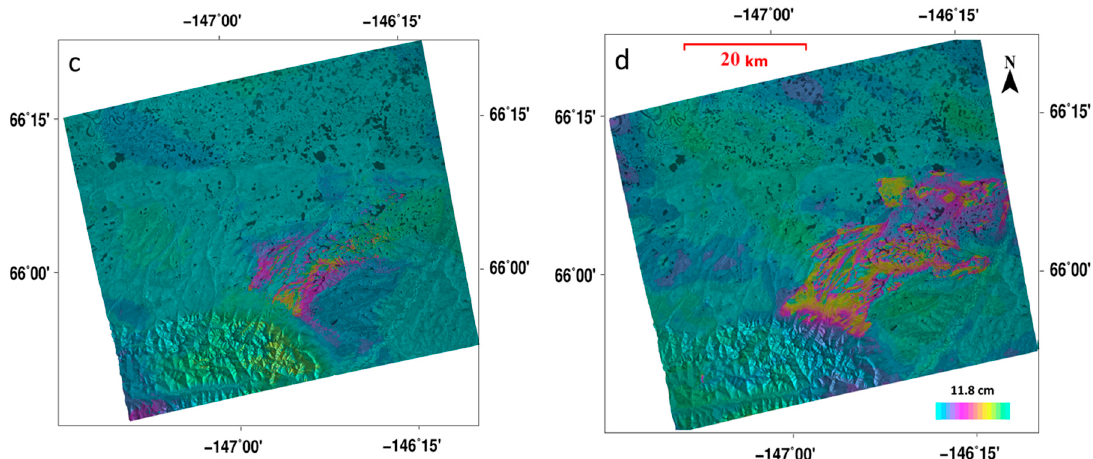
Figure 4. Unwrapped interferogram between images ( a ) 25 May 2010 and 8 July 2010 (track 251), ( b ) 8 July 2010 and 23 August 2010 (track 251), ( c ) 9 June 2010 and 25 July 2010 (track 252), and ( d ) 25 July 2010 and 9 September 2010 (track 252).